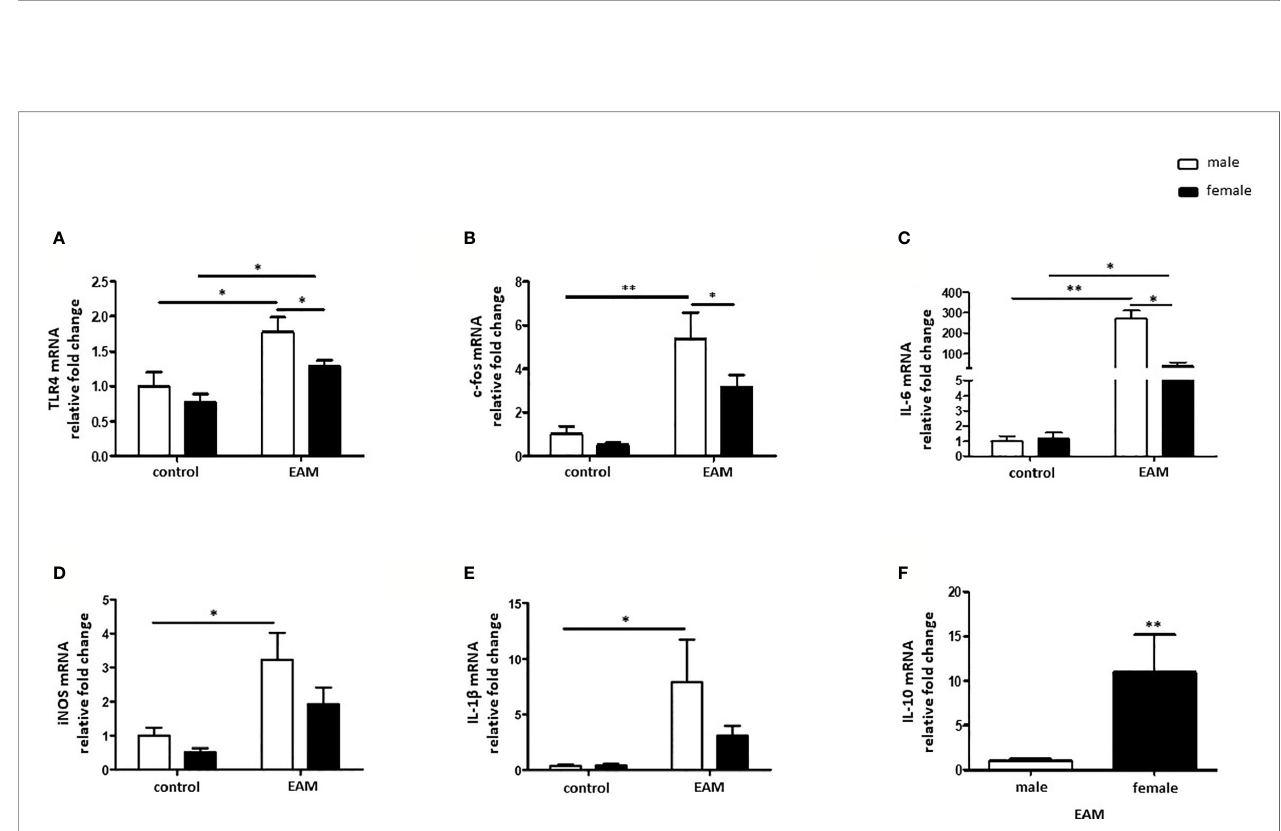
FIGURE 5 | Sex differences in the in fl ammatory response in the EAM model. Real-time PCR analysis of TLR4 (A) , c-fos (B) , IL-6 (C) , iNOS (D) , IL-1 b (E) and IL-10 (F) in rat cardiac tissue lysates from control or EAM, male ( ♂ ) and female ( ♀ ). Data are shown as the mean ± SEM (n= 5-12). *p < 0.05, **p <